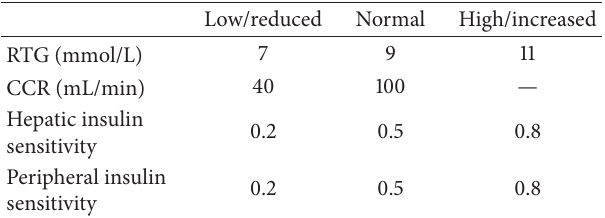
Table 1: Parameter pre-set values for the AIDA online (http://www .2aida.net) web-based diabetes simulator.